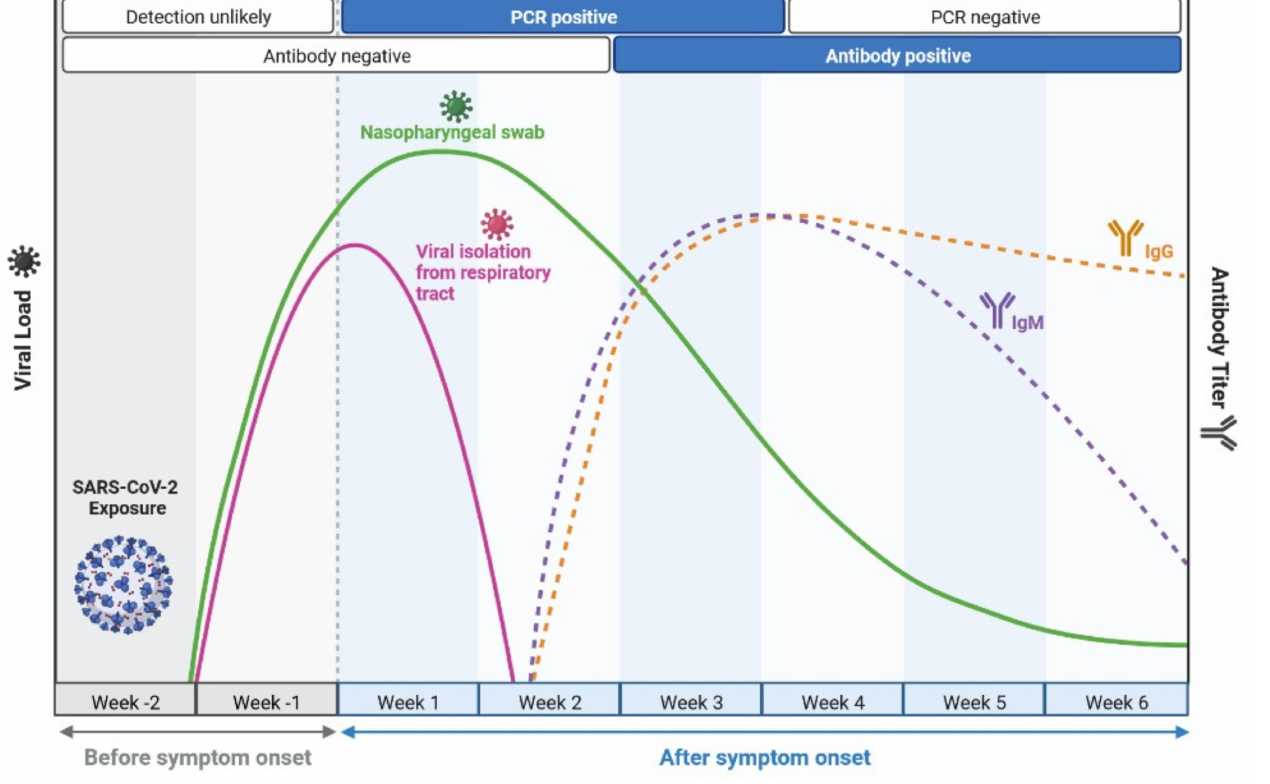
Figure 4. A time course of COVID infection and test positivity by either PCR-based or serological (antibody titre) testing. Notably, PCR tests are positive earlier in disease course, and serological tests are positive later in the disease